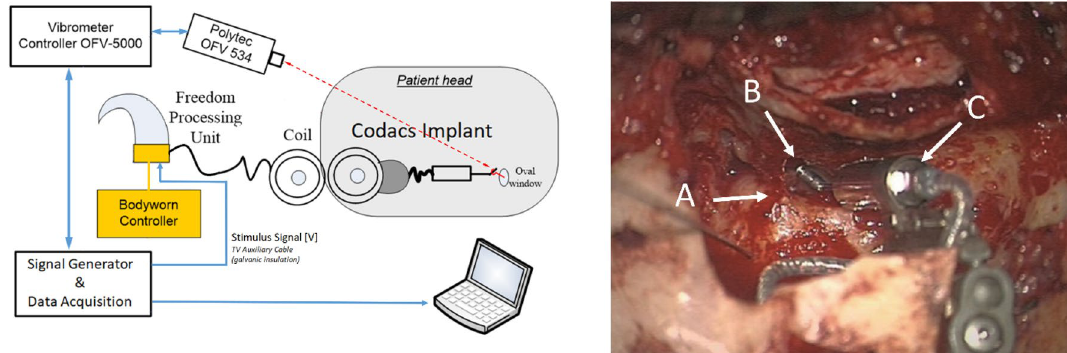
Figure 3. Left panel: Setup for the intraoperative measurement of the electro-mechanical transfer function. The white noise signal is generated on a computer controlled data acquisition system driving the input of a modified implant processor. The vibration response of the artificial incus of the actuator is measured by the laser Doppler vibrometer and recorded with the data acquisition system. Right panel: Surgical situation during intraoperative measurement: (A) piston prosthesis reaching into the cochlea through a stapedotomy, (B) artificial incus of the actuator, (C) Codacs actuator